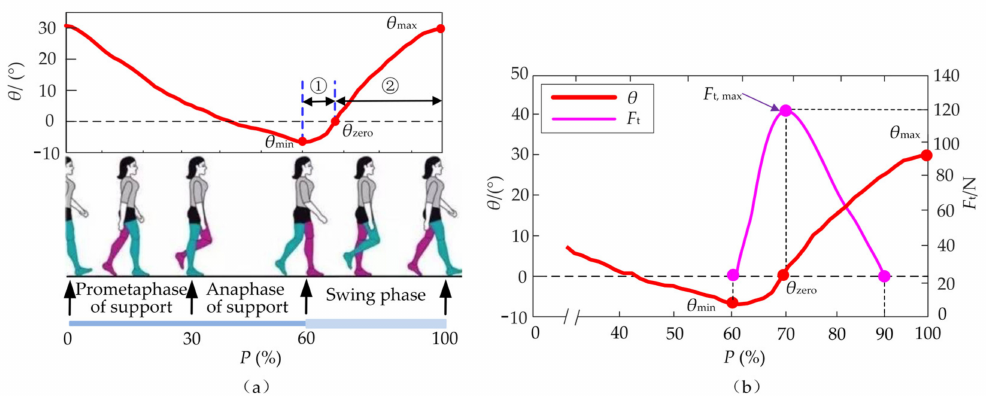
Figure 3. Profile of auxiliary forces F t . ( a ) The hip flexion is divided into two stages: 1 (cid:13) The first stage is from θ min to the zero-point θ zero , 2 (cid:13) The second one is from θ zero to θ max . ( b ) The profile of the auxiliary force F t begins at t = t θ ,min , reaches the peak value F t, max at t = t θ ,zero , and ends at t = t 90% .